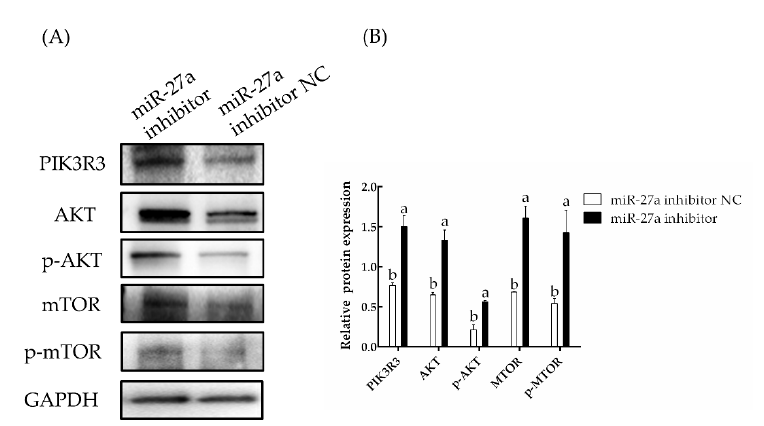
Figure 11. The effect of miR-27a inhibition on the expression and activation of proteins in the MTOR/AKT signaling pathway was determined by Western blotting. ( A ) Proteins were extracted 48 h after transfection with an miR-27a inhibitor or a negative control (NC) and analyzed with the noted antibodies. ( B ). The band densities in panel ( A ) were quantified with ImageJ. The different small letters (a, b) in the same graph indicate that the difference between groups is statistically significant ( p < 0.05). EdU and CCK-8 assays (Figure 12) showed that the proliferation of HFSCs was significantly enhanced by the miR-27a inhibitor ( p < 0.05), and the rate of apoptosis was clearly lower in cells transfected with the miR-27a inhibitor compared to control (Figure